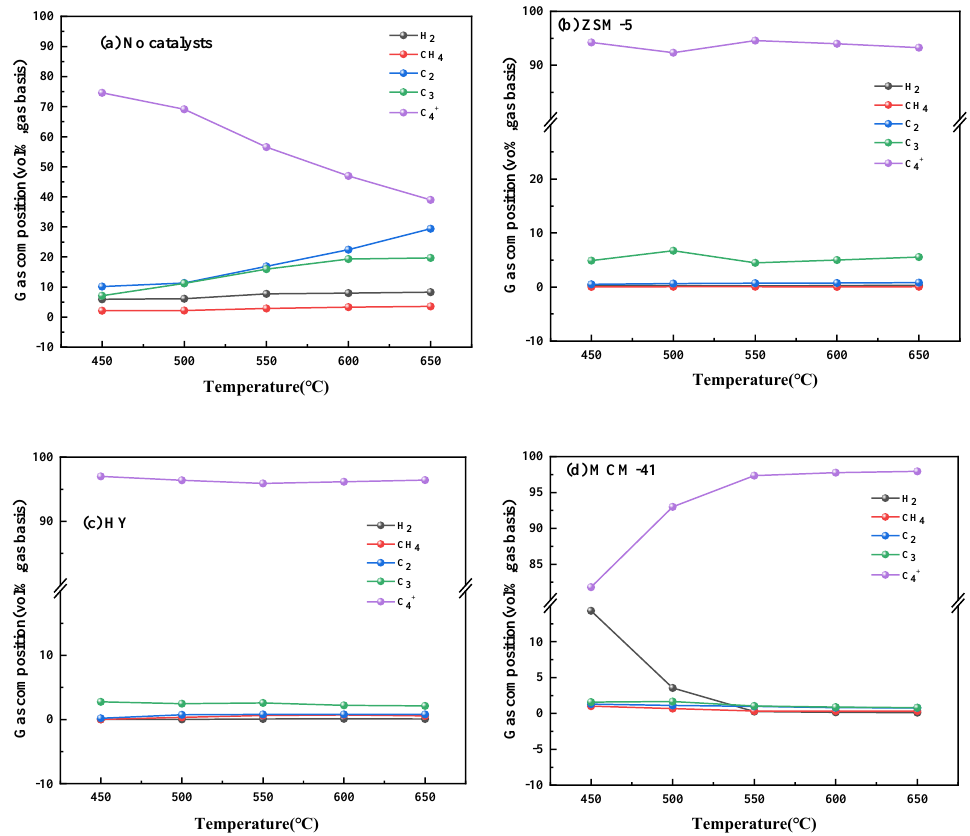
Figure 4. Comparison of gas − phase composition during LDPE pyrolysis with three kinds of catalysts ( a ) no catalysts; ( b ) ZSM-5; ( c ) HY; ( d ) MCM − 41.